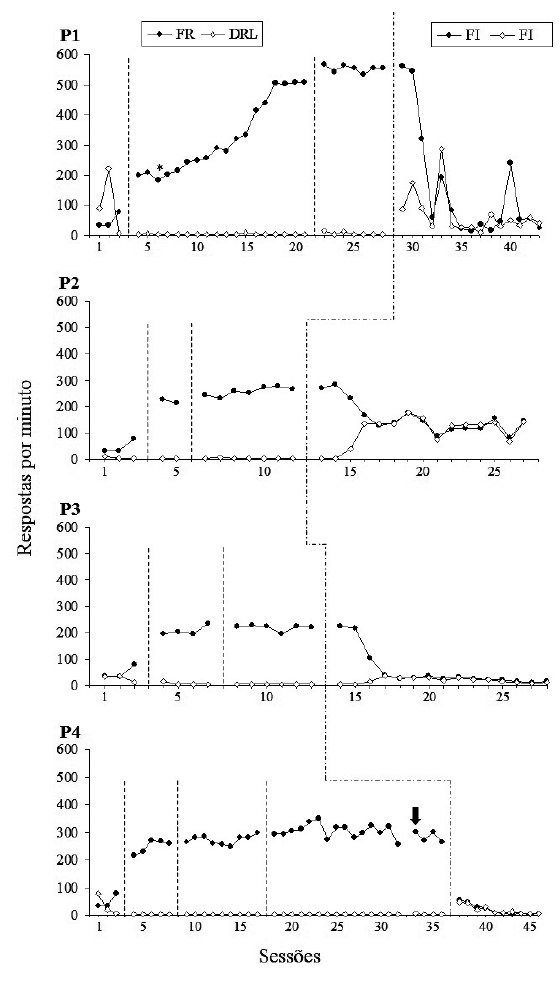
Figura 1 . Taxas de respostas (em respostas por minuto) de cada participante durante todas as fases do experimento. As linhas pontilhadas indicam as mudanças de fase. Os círculos cheios e vazios indicam, respectivamente, as taxas de respostas nos com- ponentes em que o botão de resposta era verde –FR (Fases 1, 2 e 3) e FI (Fase 4) e vermelho –DRL (Fases 1, 2 e 3) e FI (Fase 4). A seta no grá fi co de P4 indica a primeira de quatro sessões adicionais na Fase 4. Na Fase 5 (P4 apenas), o botão de resposta era preto (Componente 1) e branco (Componente